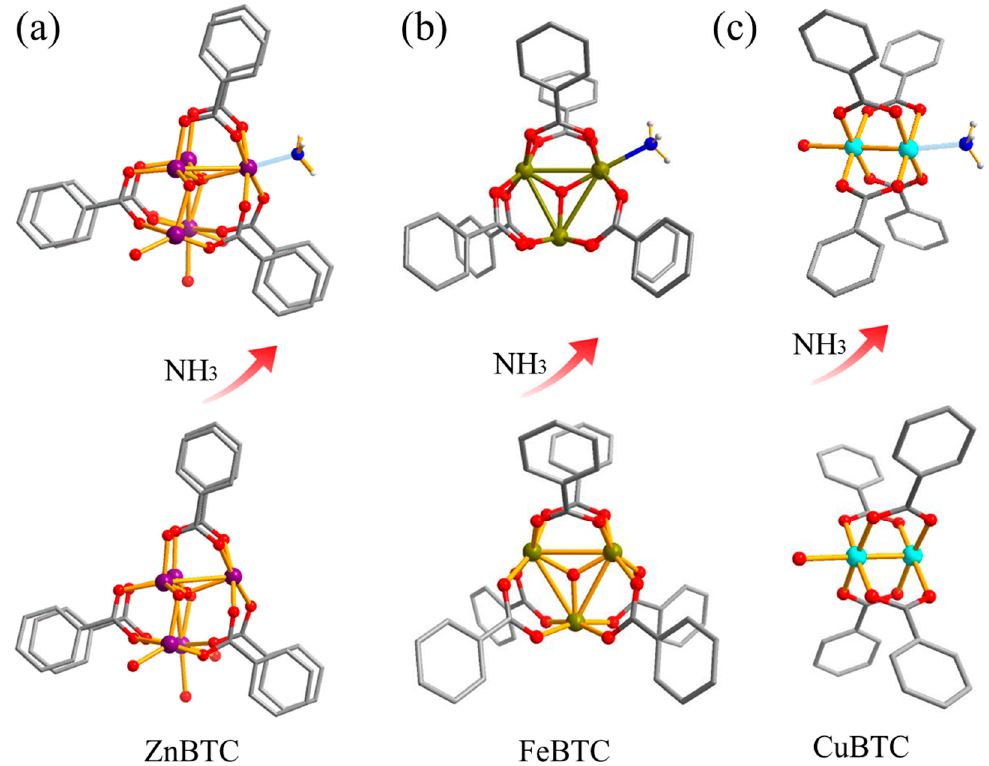
Figure 5. Adsorption configuration and distance of NH 3 on metal site: ( a ) ZnBTC, ( b ) FeBTC and ( c ) CuBTC.